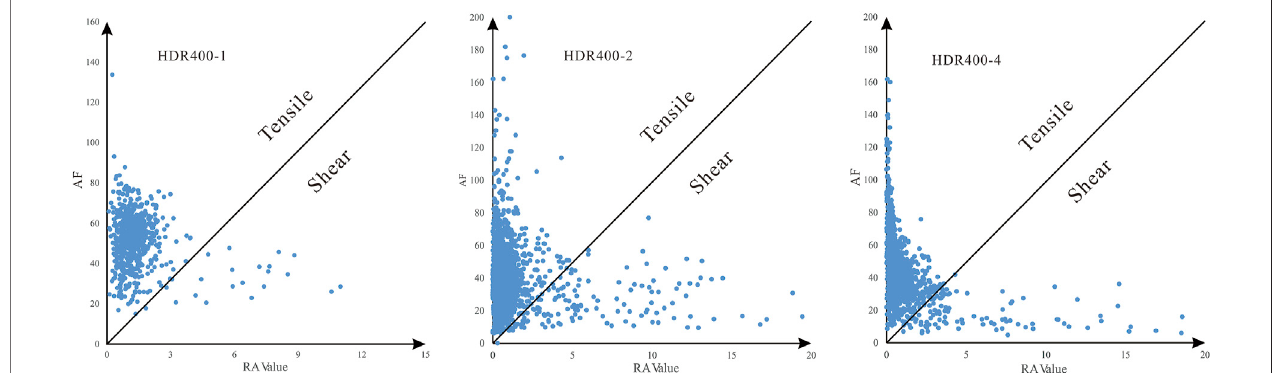
FIGURE 12 | Classi fi cation of tensile and shear